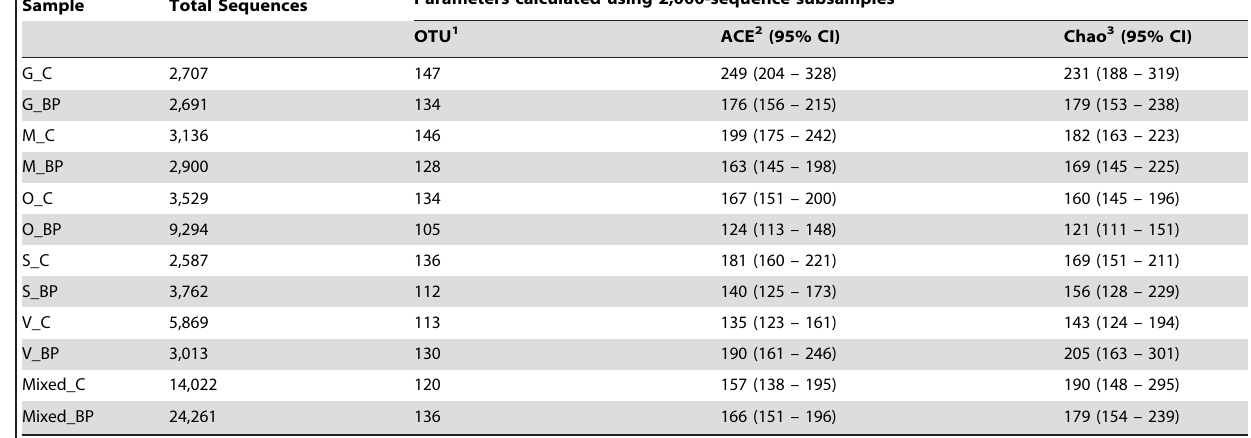
Table 1. Number of sequences obtained from fecal samples from dogs fed either a low-fiber diet (C) or a fiber-supplemented diet (BP) and similarity-based species richness estimates obtained from 2000-sequence subsamples using DOTUR.